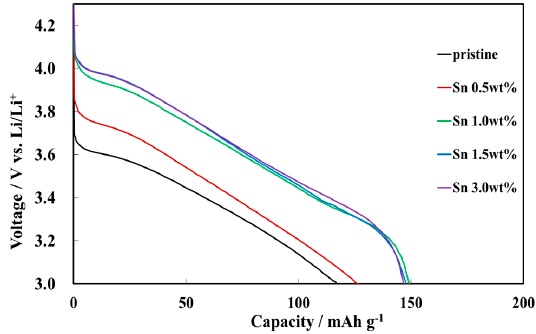
Figure 7. Discharge profile of the cathode active materials at 5 C.